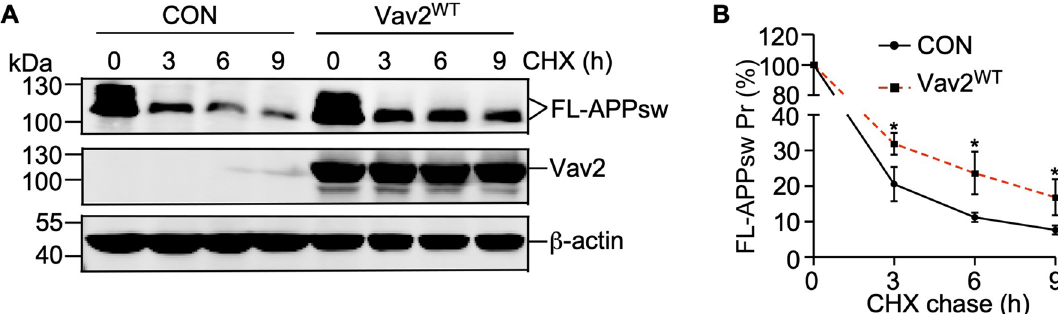
Figure 6. Vav2 stabilizes APP protein turnover. ( A ) Vav2 influences the degradation rate of APP protein. 20E2 cells were transfected with Vav2 WT or empty control. Forty-eight hours after transfection, cells were treated with 150 μg/mL of CHX for indicated times. Cell lysates were detected for FL-APPsw and Vav2 by Western blot, β-actin was used as loading control. Original blots are presented in Supplementary Figures. ( B )